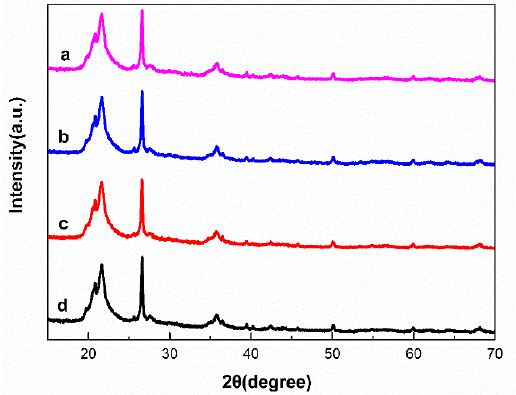
Figure 4. XRD patterns of ( a ) SC, ( b ) A-SC, ( c ) Glu–A-SC, and ( d )